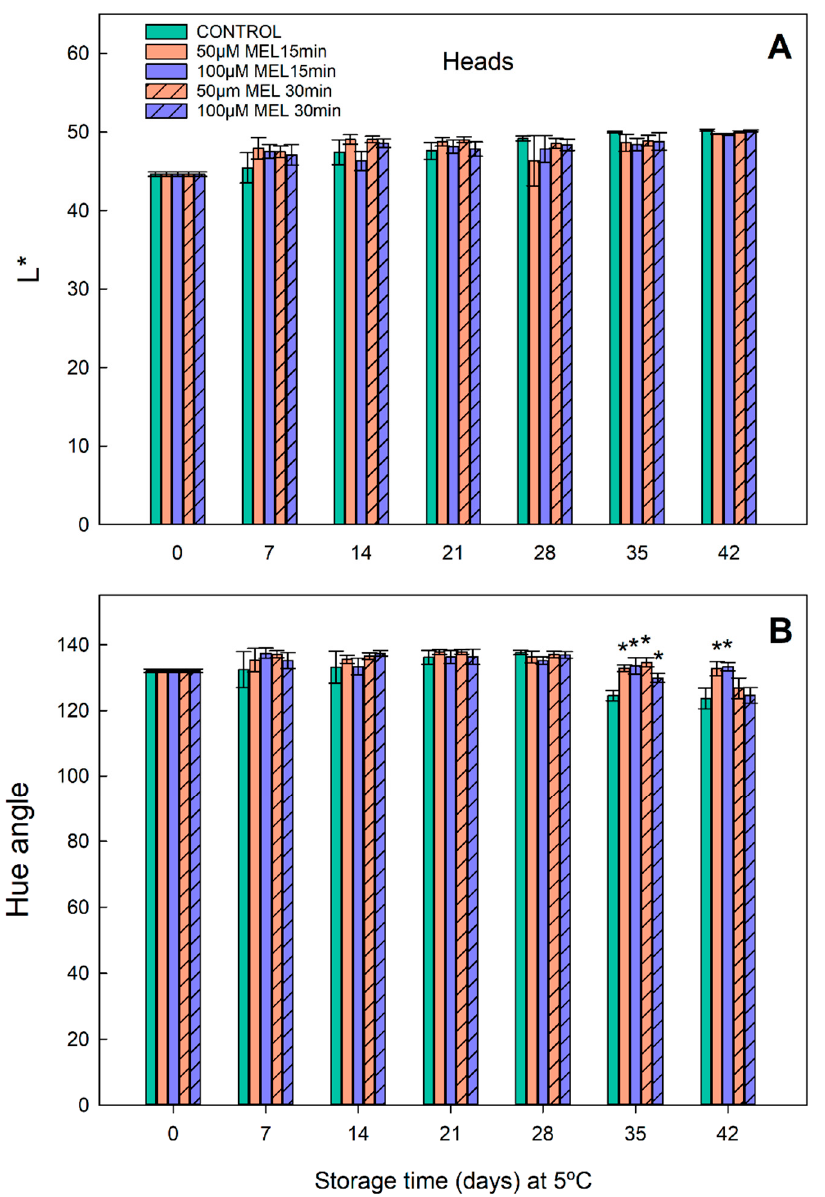
Figure 4. Color parameters in broccoli heads stored at 5 °C. ( A ) Luminosity (L*) and ( B ) Hue angle of broccoli heads treated with 50 and 100 μ M of melatonin during 15 and 30 min and stored in the dark, at 5 °C, for 0, 7, 14, 21, 28, 35 and 42 days. Each bar represents the mean value ± standard error ( n = 3) obtained for each concentration used. Asterisks indicate significant differences with the control of that day based on a Tukey HSD test with a significance level of p < 0.05.